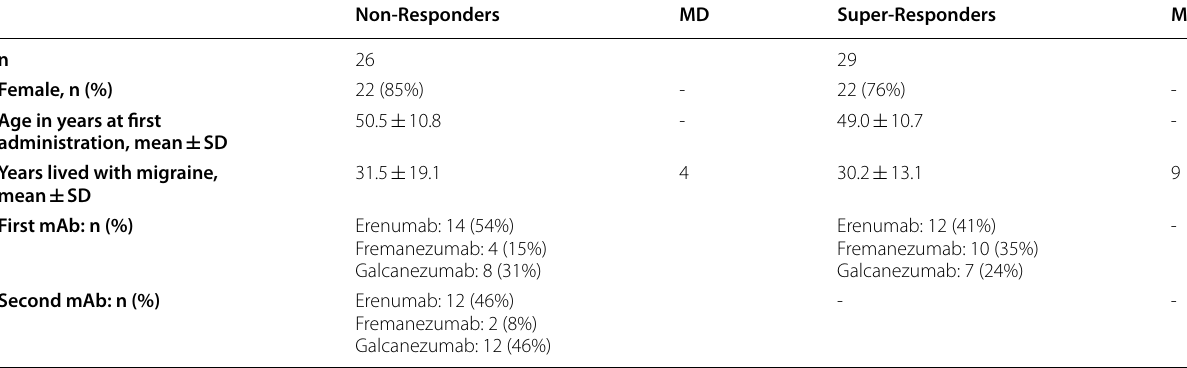
Abbr.: SD Standard deviation, MD Missing